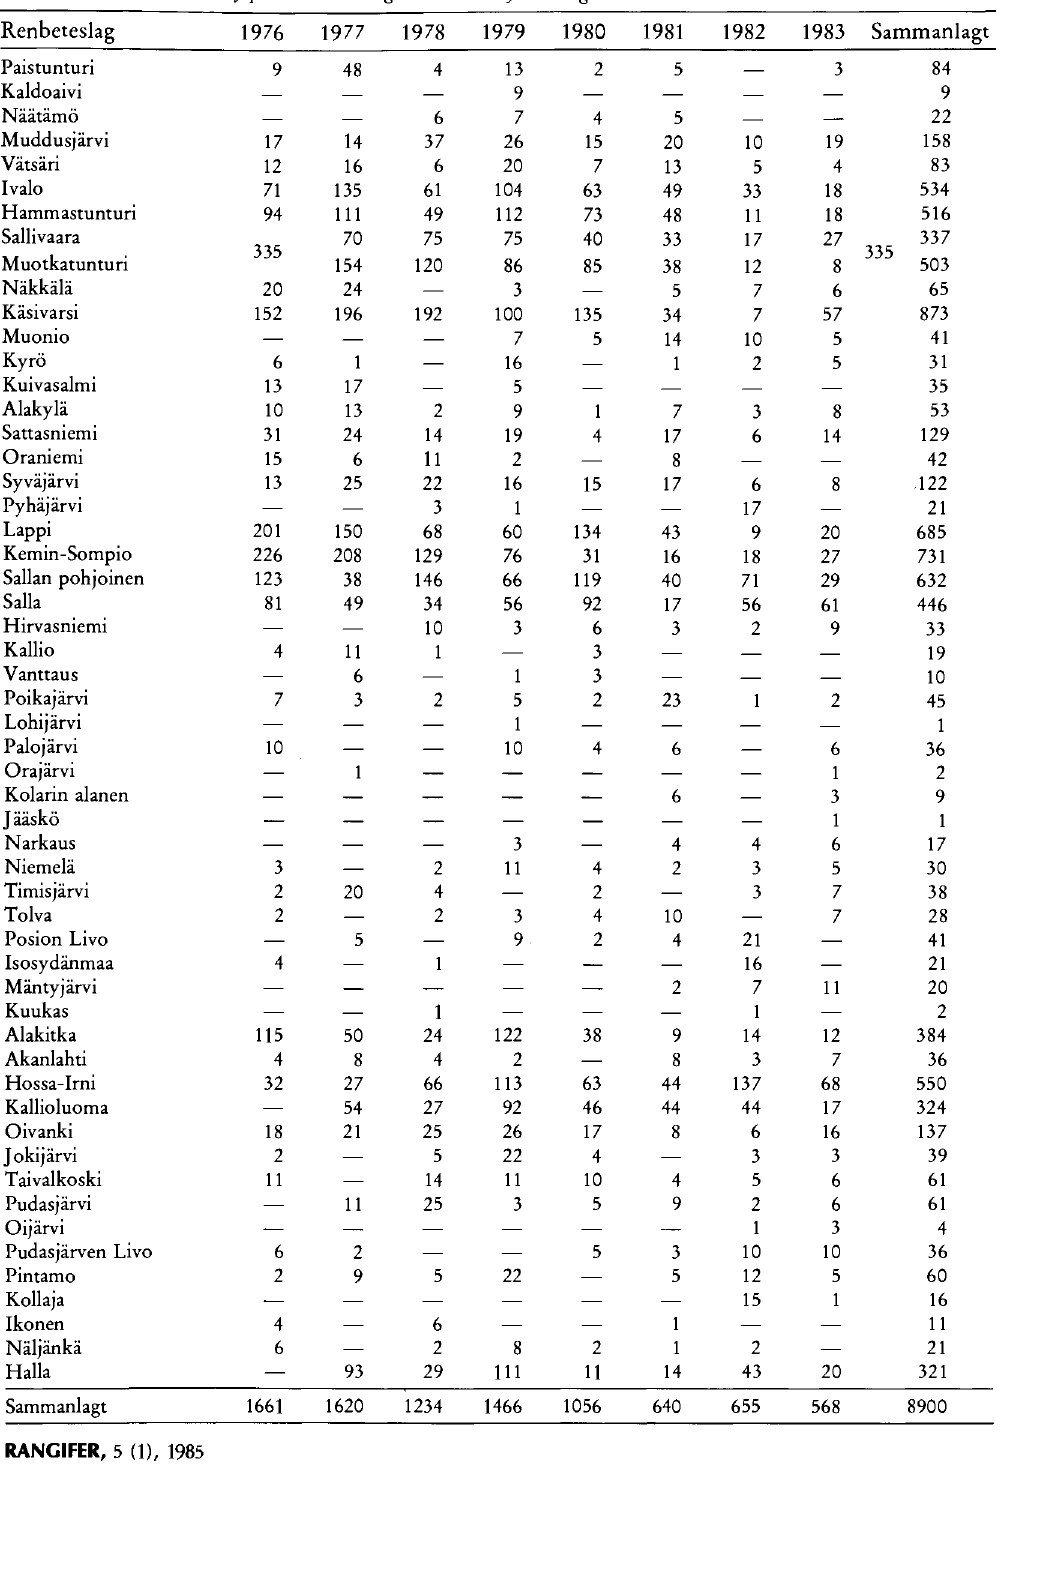
Table 1. Reindeer killed by predators during 1976-1983 by h, erding areas.